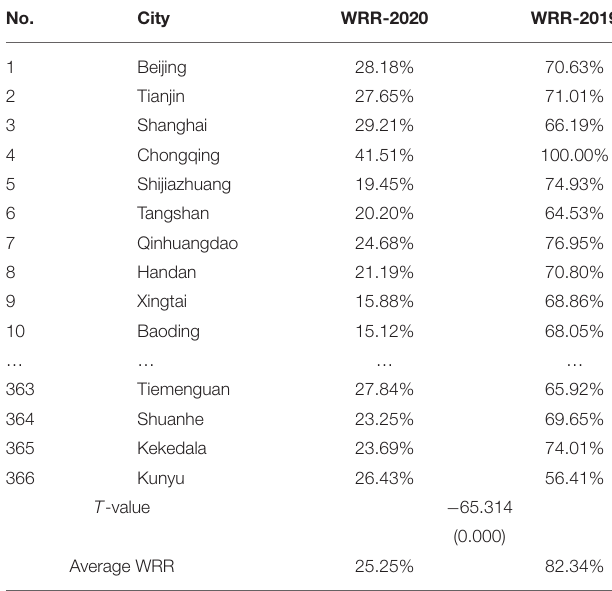
TABLE 2 | WRR of 366 cities in China (Feb. 8, 2020 and Feb. 19,